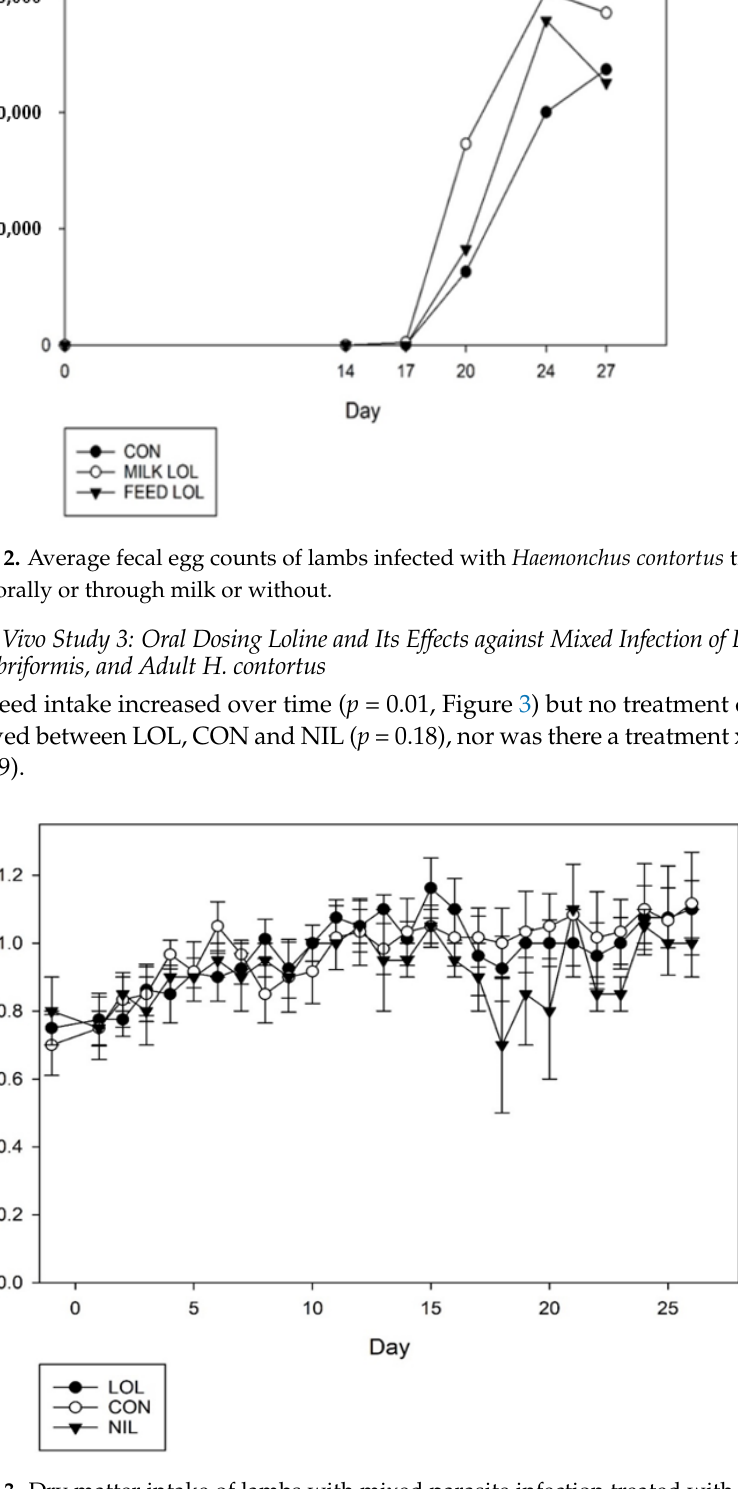
Figure 3. Dry matter intake of lambs with mixed parasite infection treated with a meadow fescue seed extract with (LOL) or without loline (NIL), or non - treated (CON) .